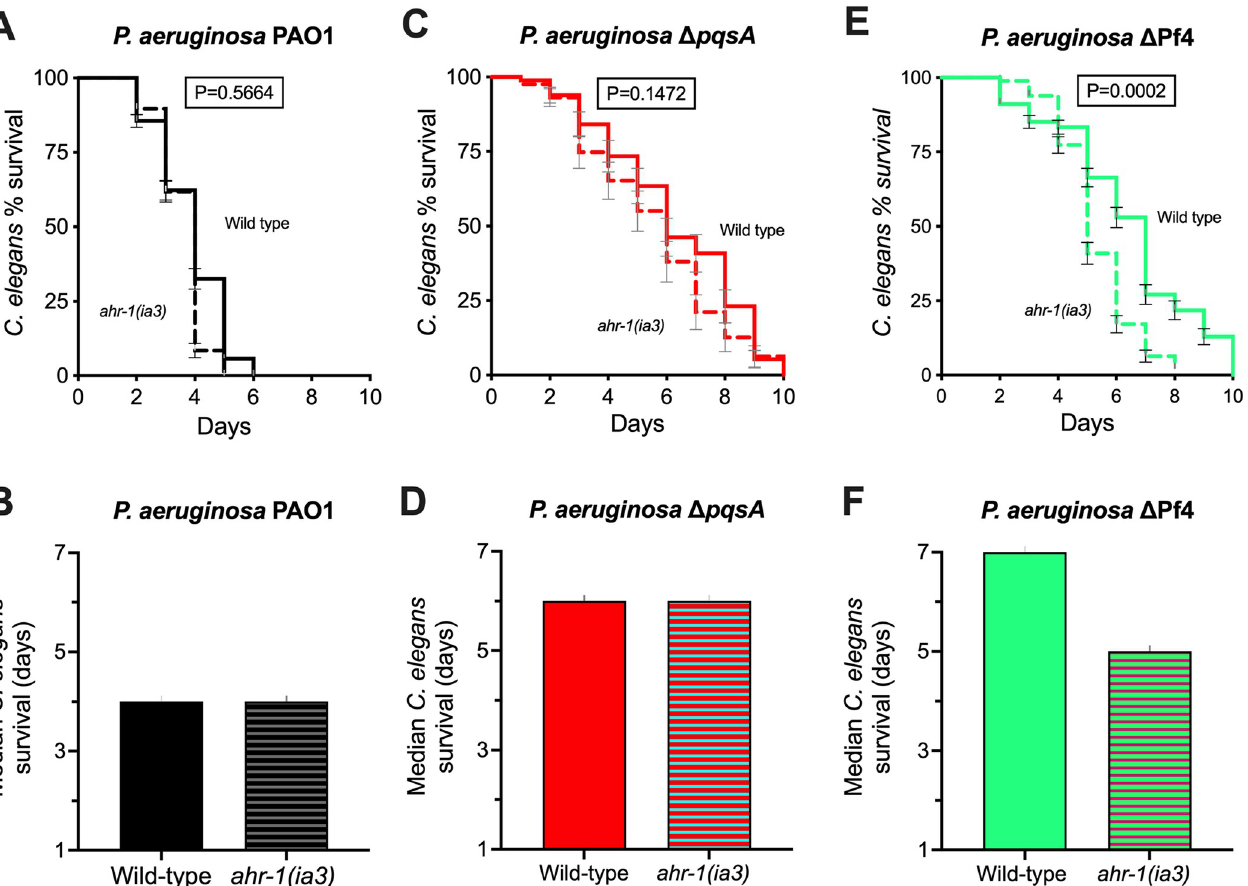
Fig 6. Inactivation of AhR signaling in C . elegans enhances Δ Pf4 virulence. (A, C, and E) Kaplan-Meier survival curve analysis (Log-rank) of wild-type N2 or isogenic ahr-1(ia3) C . elegans maintained on lawns of P . aeruginosa PAO1, Δ pqsA , or Δ Pf4 for the indicated times. N = 3 groups of 90 animals per condition (270 animals total per condition). Error bars represent standard error of the mean. P-values of pairwise log-rank survival curve analyses are shown. (B, D, and F) The median survival of C . elegans in days was plotted for each group.